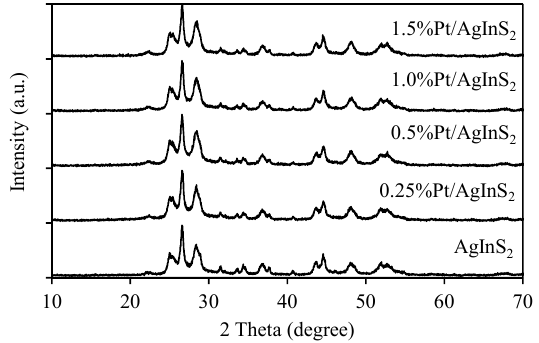
Figure 1. XRD patterns of AgInS 2 and Pt / AgInS 2 photocatalysts.